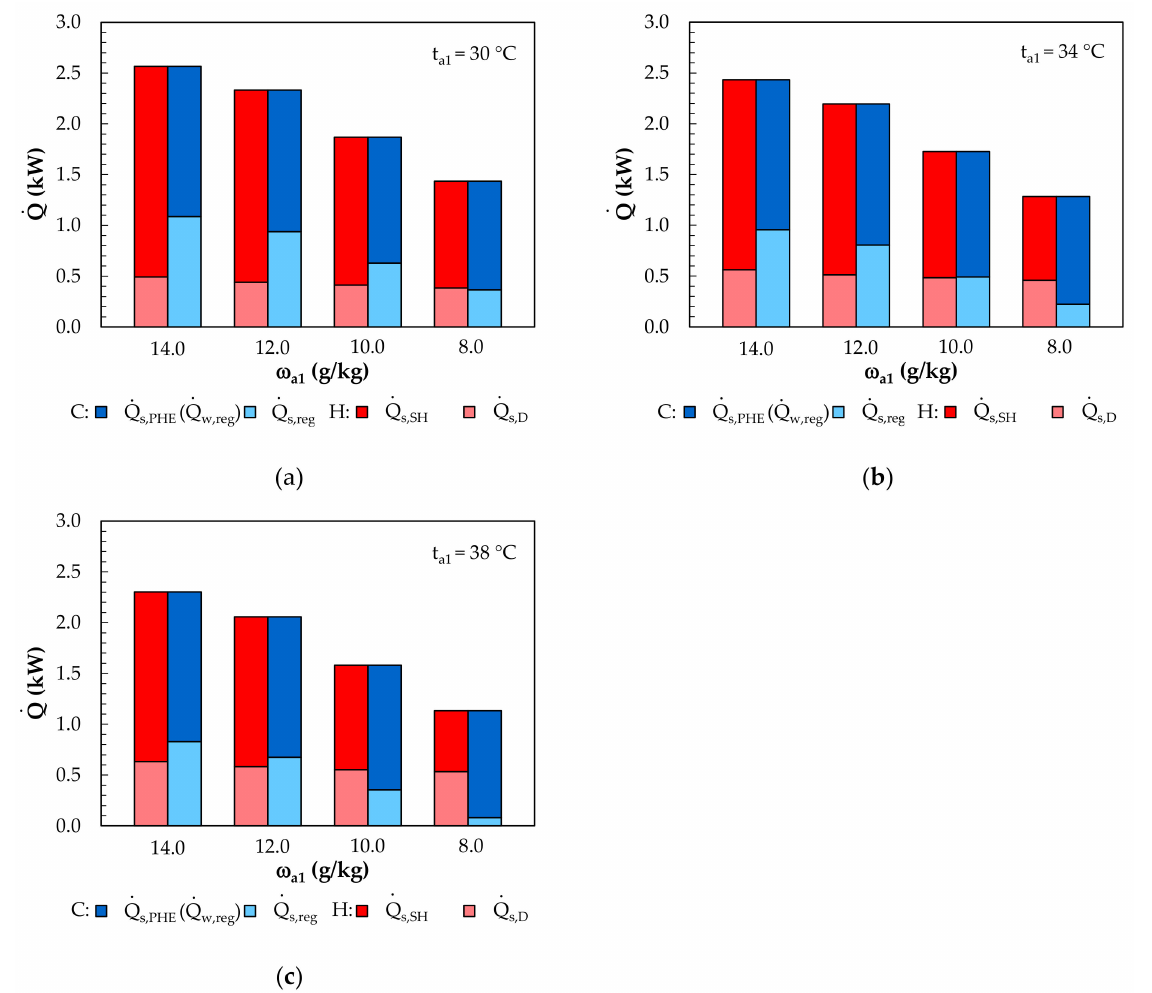
Figure 16. Effect of the inlet air humidity ratio on the heat and cooling capacity of the solution side (C–cooling, H–heating): ( a ) for an inlet air temperature of 30 ◦ C; ( b ) for an inlet air temperature of 34 ◦ C; ( c ) for an inlet air temperature of 38 ◦ C. The effects of the outdoor air parameters on the COP of the system and the cooling capacity of the supply air are shown in Figure 17. The highest COP and were obtained at the lowest outdoor air humidity ratio and at a particular outdoor air temperature. In such conditions, the highest drop in the air temperature in the MEC was obtained, and the inlet temperature of the solution for the dehumidifier was the lowest, resulting in the lowest air mixture temperatures and, thus, the highest